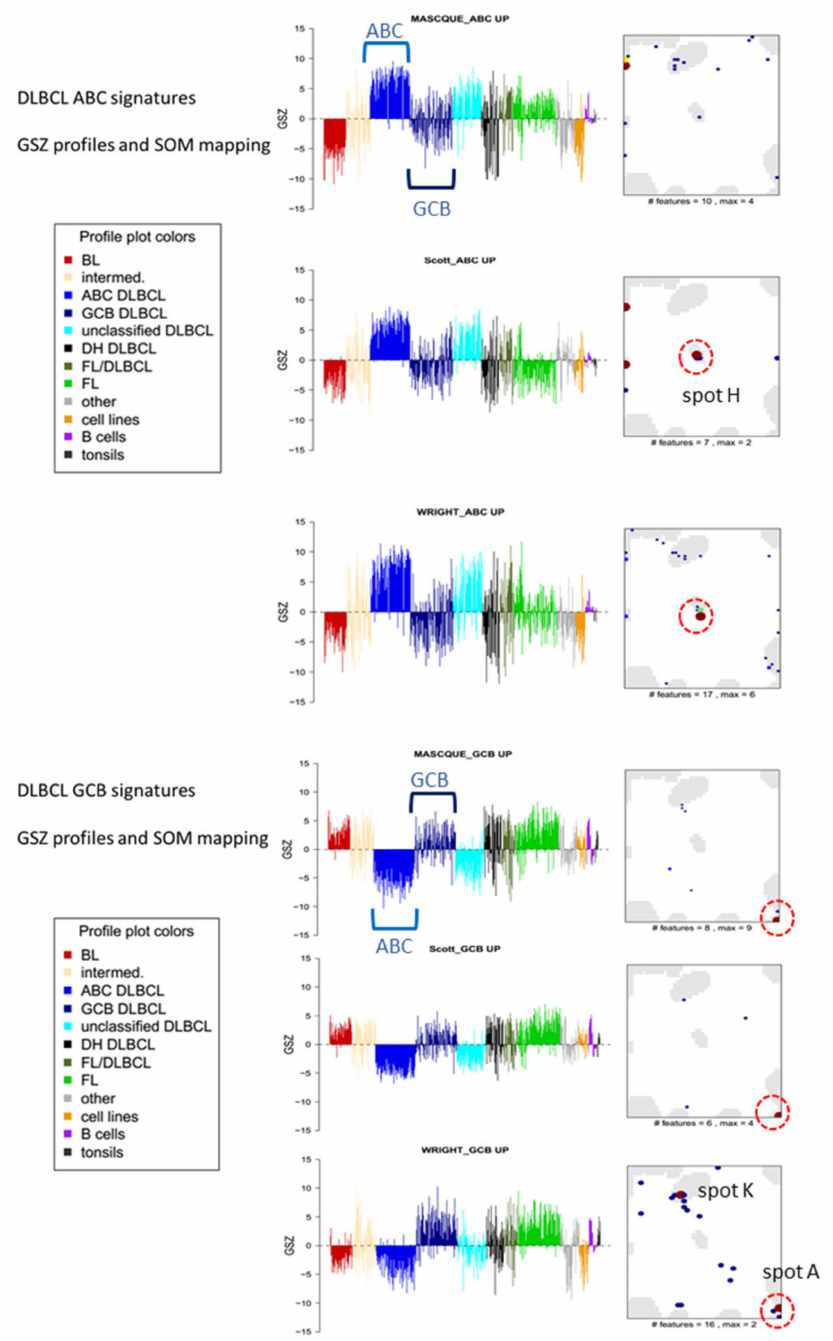
Figure A9. Characteristics of ABC-vs-GCB DLBCL signatures: GSZ-profiles of the ABC_up signatures show high (GSZ >0) values for ABC-DLBCL (light blue) and unclassified DLBCL (cyan) and low values (GSZ <0) for GCB-DLBCL (dark blue) and BL (red). SOM mapping indicates accumulation of signature genes, first of all, in/near spot H but also in/near spots K and F (red circles). Espe- cially, part of the Masque-ABC_up signature genes are found in spots F/K which associate with stroma/inflammation and healthy B-cell functions, respectively, giving rise to upregulation in FL. In contrast, Scott-ABC_up and Wright-ABC_up signatures accumulate in spot H, which associates with deactivated expression in FL. The GCB_up set of Masque et al. virtually contains only genes from spot A, which explains their similar